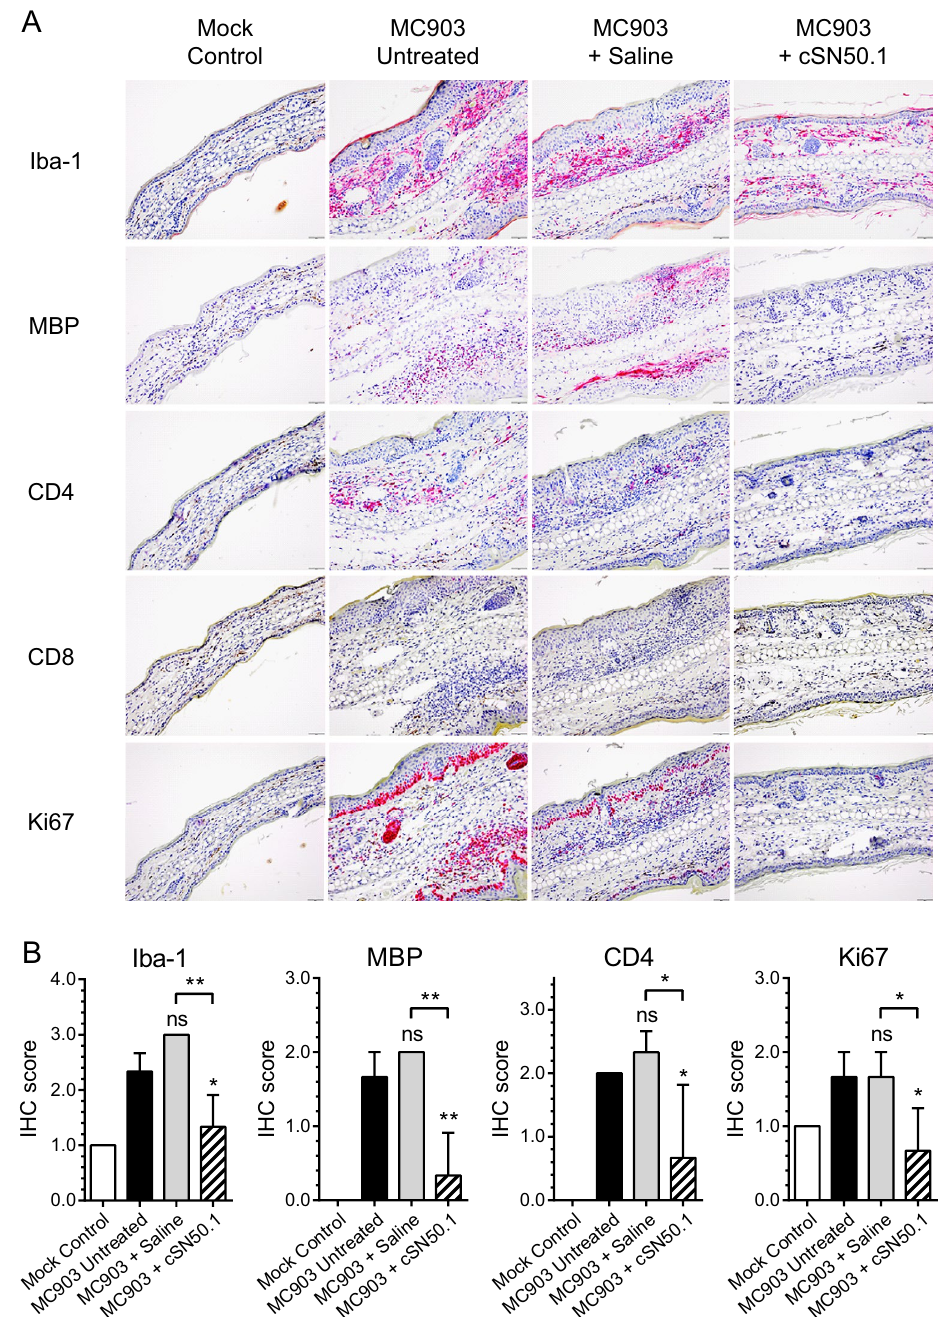
Figure 4. The attenuation of MC903-induced skin inflammation in the murine pinna by NTCI (cSN50.1 peptide) treatment. ( A ) Exposure to MC903 without treatment or treated with a saline control leads to cellular infiltration comprising predominately macrophages (Iba-1) and eosinophiles (major basic protein or MBP) combined with an influx of CD4 + T cells (CD4), leading to the thickening of the pinna as compared to the mock control. Moreover, the significant immunodetection of Ki67-positive cells indicated increased cellular proliferation in the basal cell layers of the epidermis in response to MC903 12 . Treatment with NTCI (cSN50.1 peptide) reduced the cellular mediators of the inflammatory response. NTCI reduced skin edema (see also Fig. 2A). Shown are representative images of pinna samples with immunohistochemistry for key inflammatory cell markers (× 20 magnification). ( B ) A semiquantitative analysis of immunohistochemical (IHC) staining presented in panel A. Scoring was conducted according to following formulas: IHC scoring (all inflammatory cell markers): 0—No or almost undetectable immunoreactivity (IR); 1—Scattered and rare IR in the dermis; 2—Multifocal and barely coalescing IR in the dermis; 3—Diffuse IR in the dermis. IHC scoring for Ki67 in epidermis: 0—None; 1—Single cell layer IR at basal zone of epidermis; 2—IR 2—5 layers thick within the basal zone of epidermis; 3—IR > 5 cell layers thick within the basal zone of epidermis. The data is presented as a mean + S.E.M. (n = 5). The statistical analysis was performed using ordinary one-way ANOVA with an uncorrected Fisher’s LSD test for a multiple comparison, * p < 0.05, ** p <